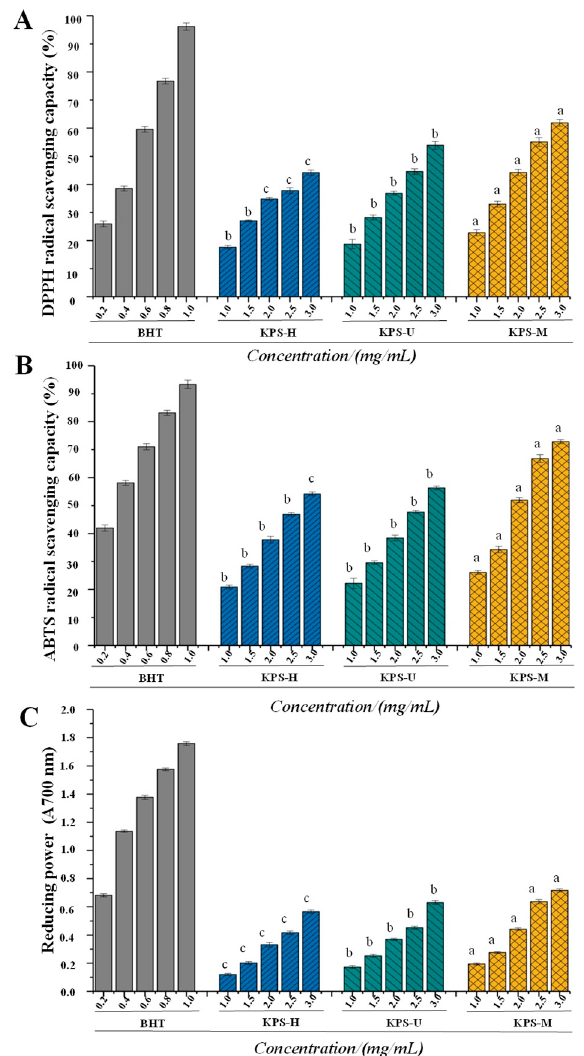
Figure 5. DPPH radical scavenging activity ( A ), ABTS radical cation scavenging activity ( B ), and reducing power ( C ) of KPS-M, KPS-U, and KPS-H. KPS-M, kiwifruit polysaccharides with microwave-assisted extraction; KPS-U, kiwifruit polysaccharides with ultrasonic-assisted extraction; KPS-H, kiwifruit polysaccharides with hot water extraction; BHT, butylated hydroxytoluene; The error bars are standard deviations; Significant ( p < 0.05) differences are shown by data bearing different letters (a–c); Statistical significances were carried out by ANOVA and Ducan’s